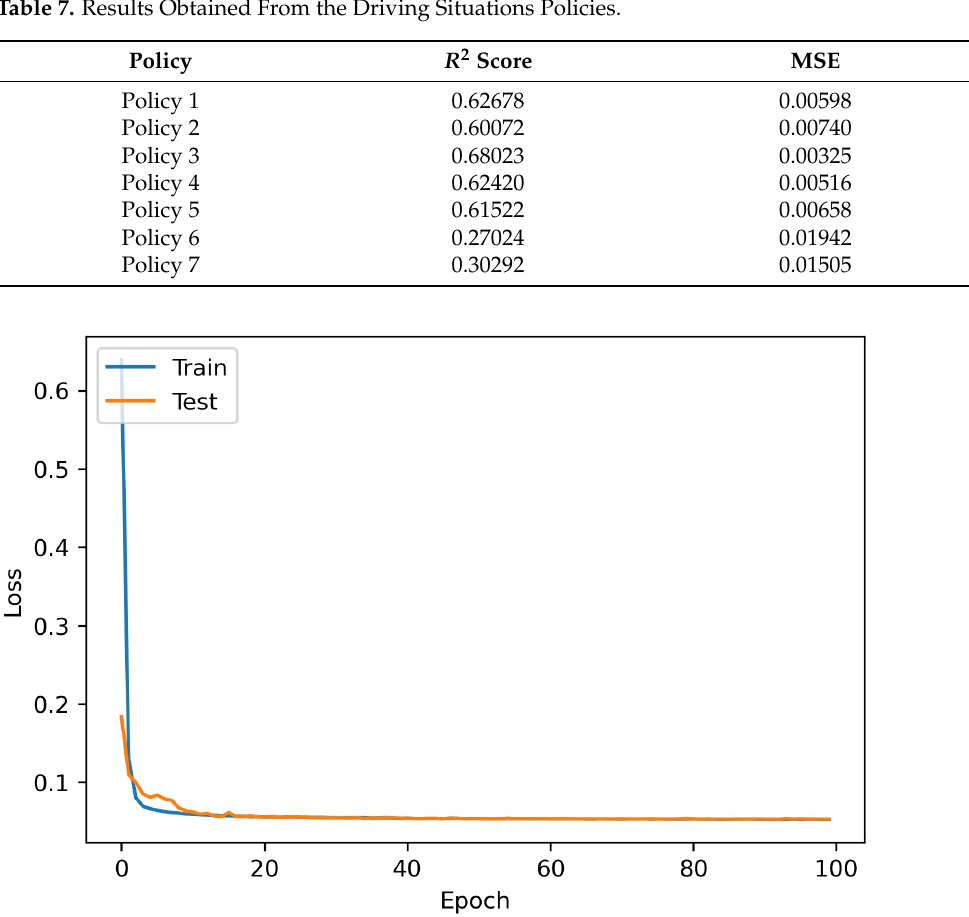
Figure 10. Example of the training of a driving policy. We can appreciate that the training and test curve are decreasing and not